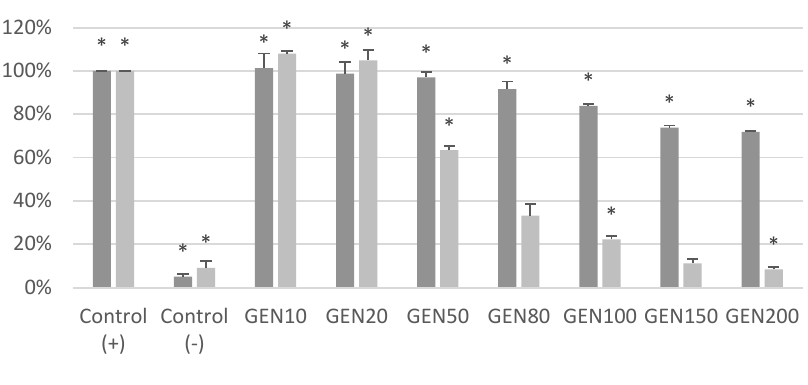
Figure 1. Cytotoxic effect of genistein at different concentrations after 24 h and 48 h on tumor MCF-7 cells in MTT test. Results are the mean ± SD of n = 5. * Statistically significant ( p < 0.05; ANOVA followed by Dunnett’s test compared with control group). Cells cultured with 0.1% DMSO were considered Control (+). Cells cultured with 15% DMSO were considered as Control ( − ).